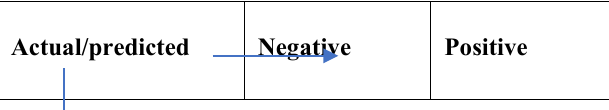
Table 2. Representation of a confusion